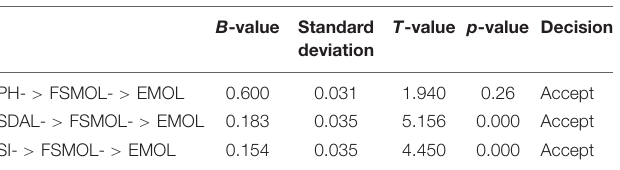
TABLE 6 | Moderator hypothesis testing.